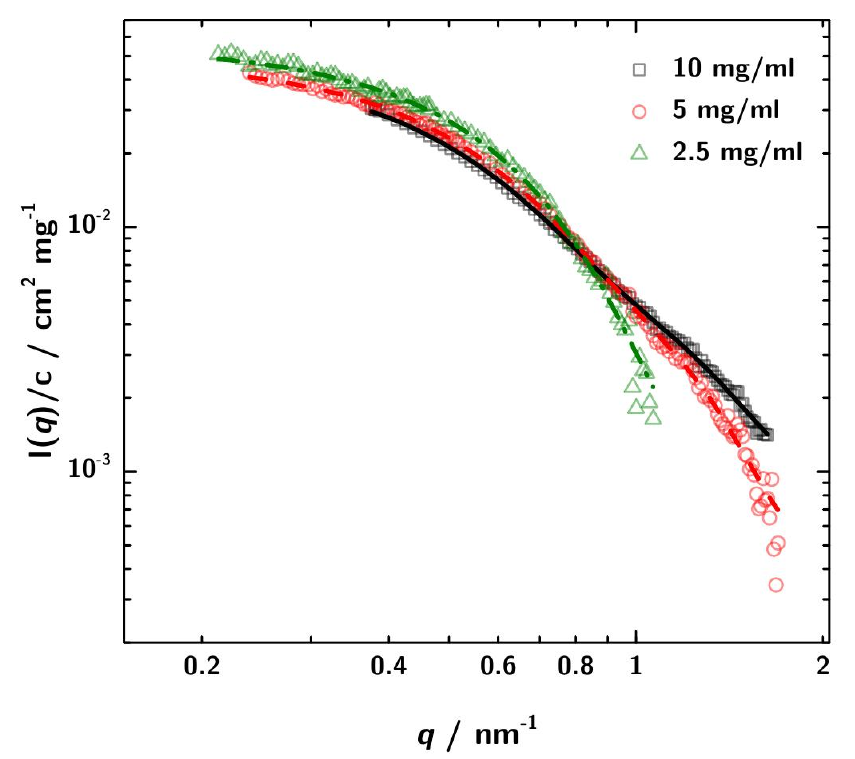
Figure 5. SAXS data normalized to concentration with the respective GNOM fits. The discrepancies between the curves can be attributed to increased interaction between the 3H3 molecules at higher concentration. These differences lead to a variation in the obtained apparent radius of gyration R g of about ± 5 to